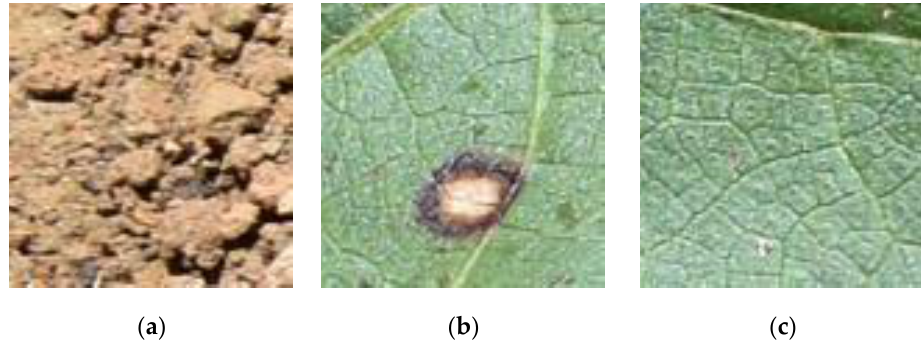
[33], starting with the acquisition of images and progressing with pre-processing, attribute